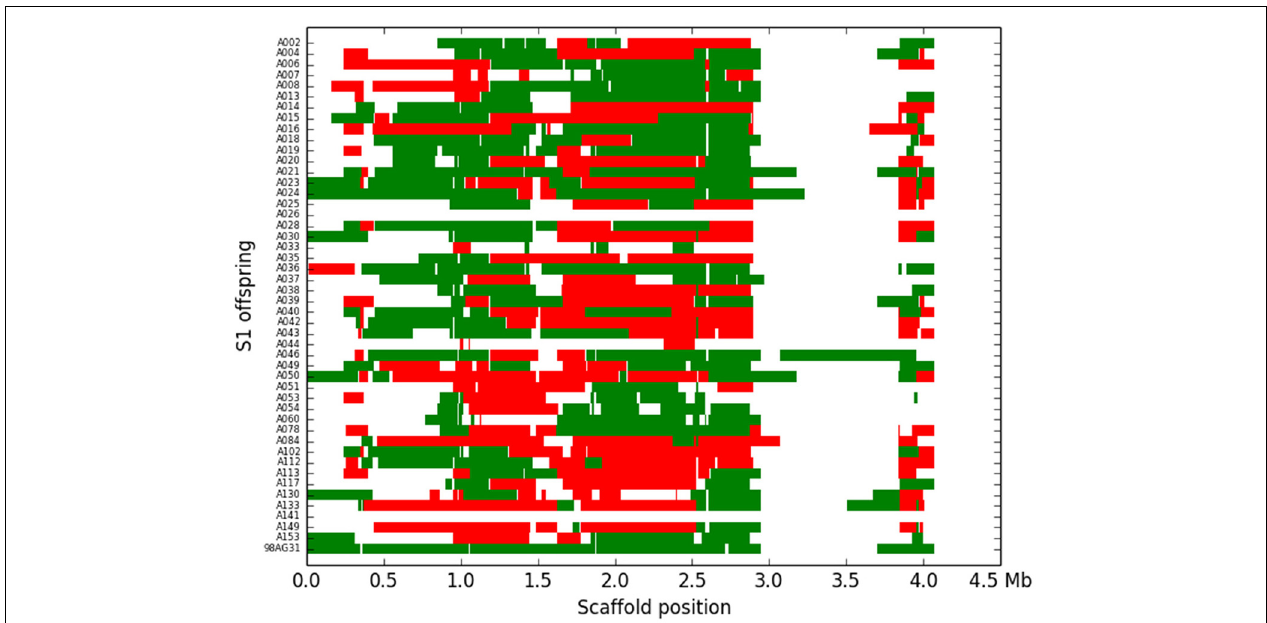
FIGURE 4 | Recombination blocks and assignment of the 48 M. larici-populina individuals (including the parental strain) for scaffold 1. Each line represents an S1 individual, the last being the parental strain. The